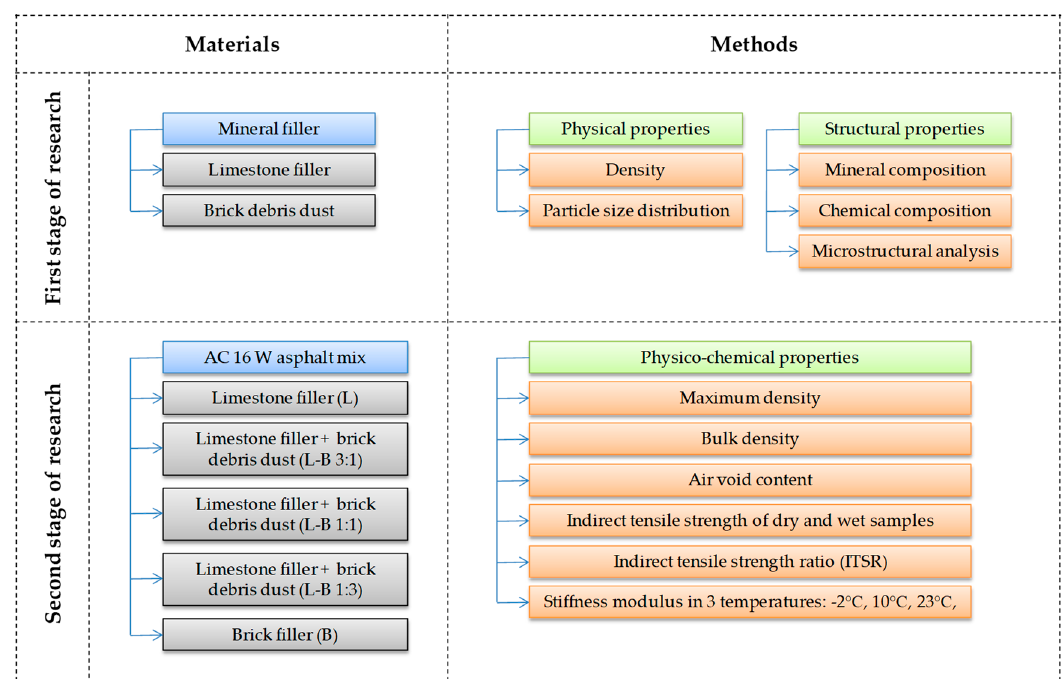
Figure 2. Methodology scheme used for this work.